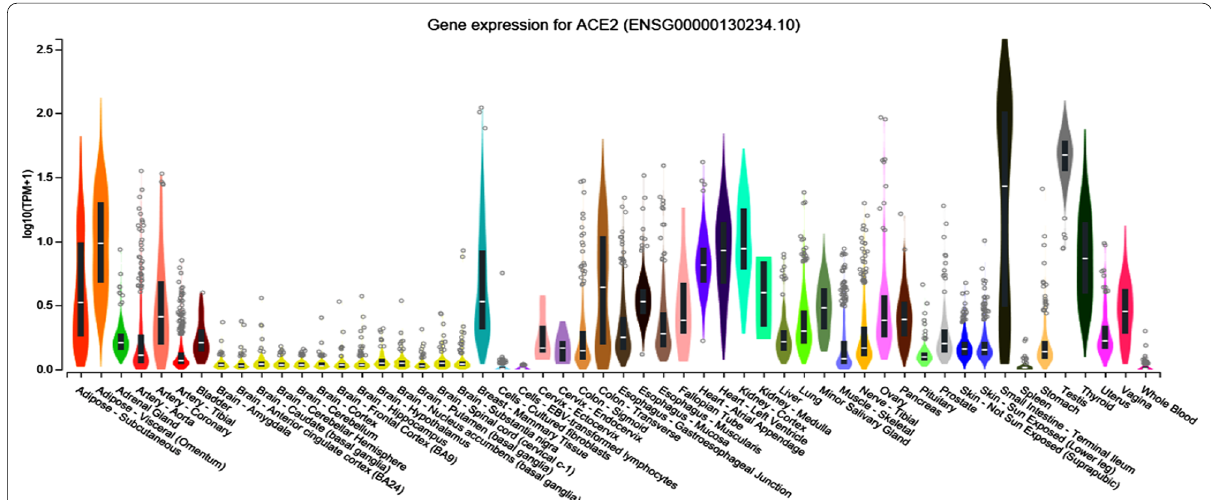
Fig. 5 ACE2 expression in different human tissues. Expression values are shown in transcripts per Million (TPM), calculated from a gene model with isoforms collapsed to a single gene. Each box plot represents the median, 25th percentile, and 75th percentile. The points below or above 1.5 times the interquartile range are considered outliers. Data Source: GTEx Analysis Release V8 (dbGaP Accession phs000424.v8.p2)